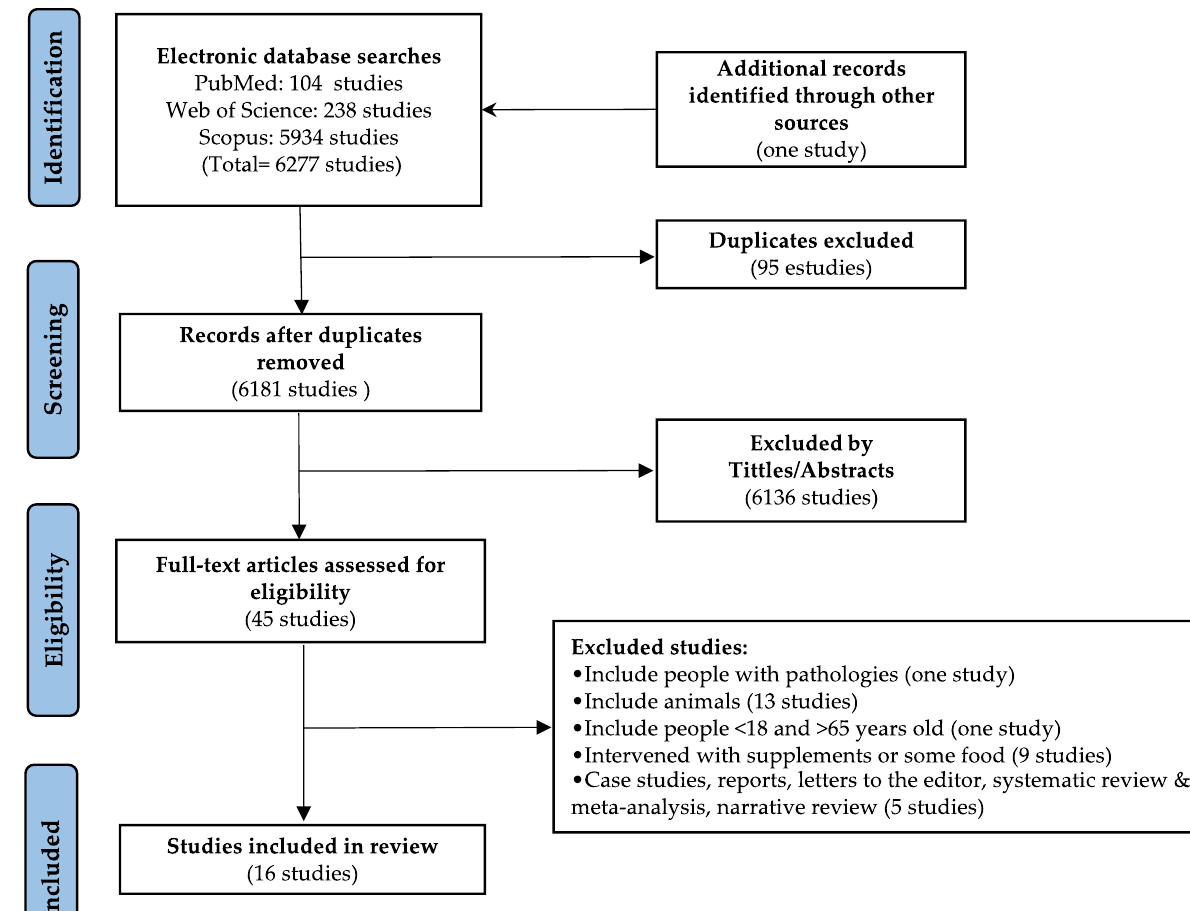
Figure 1. Flowchart of articles through the search process.